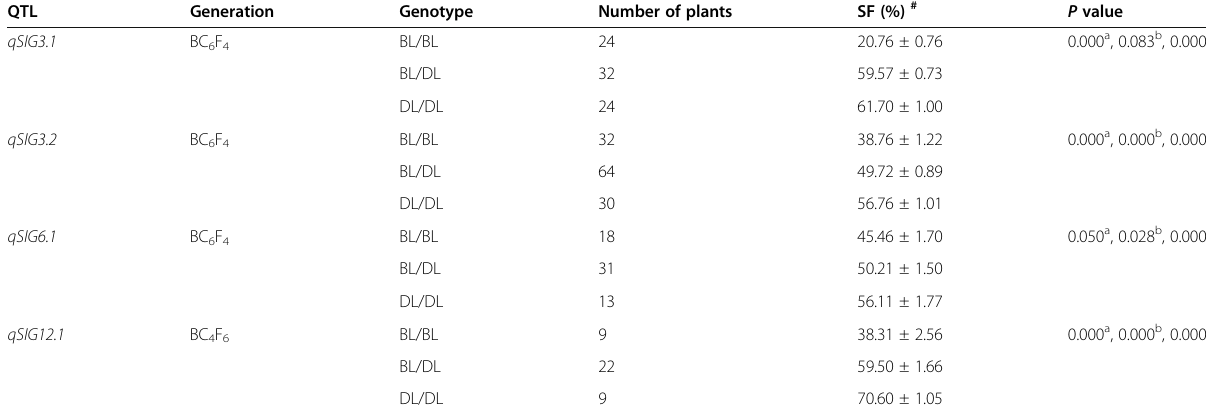
Table 4 Spikelet fertility of different genotypes in qSIG3.1 -NIL, qSIG3.2 -NIL, qSIG6.1 -NIL, and qSIG12.1 -NIL